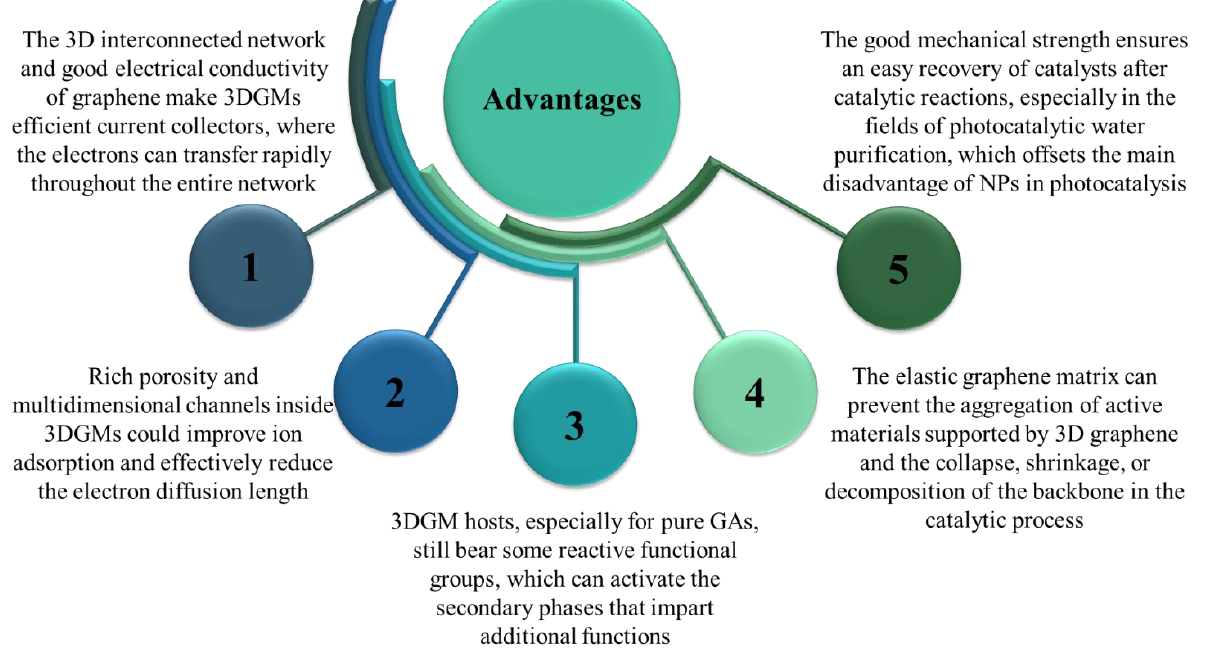
Figure 11. The main advantages of using 3DGMs in catalysis applications.